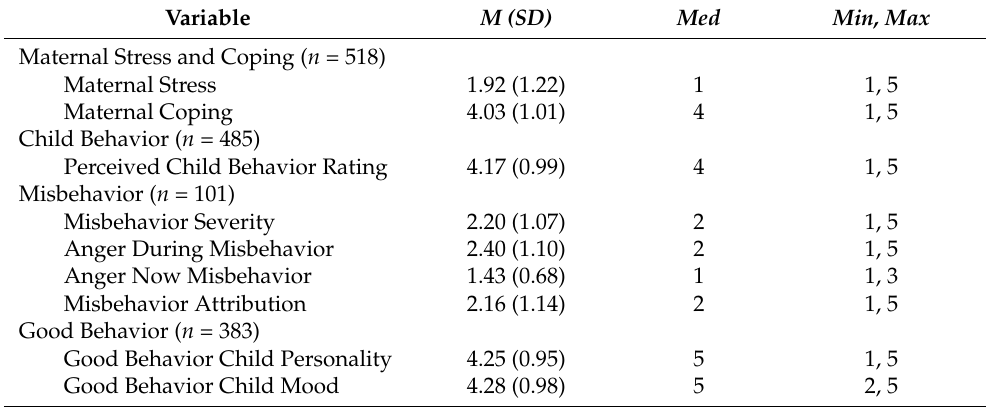
Table 1. Within-person descriptive statistics for maternal daily reports.